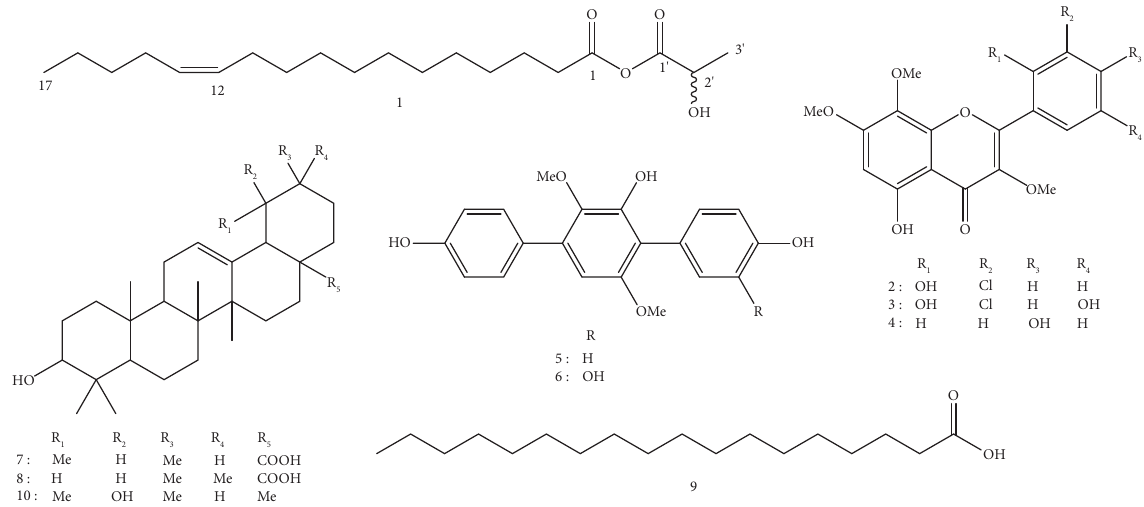
Figure 1: Chemical structures of compounds 1 to 11